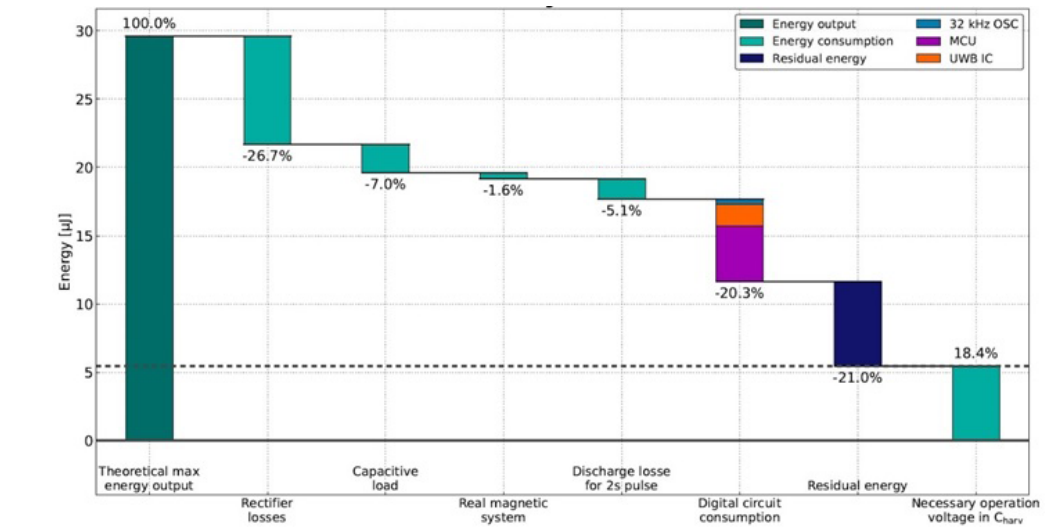
Figure 8. Energy distribution and losses during a pulsed-operation